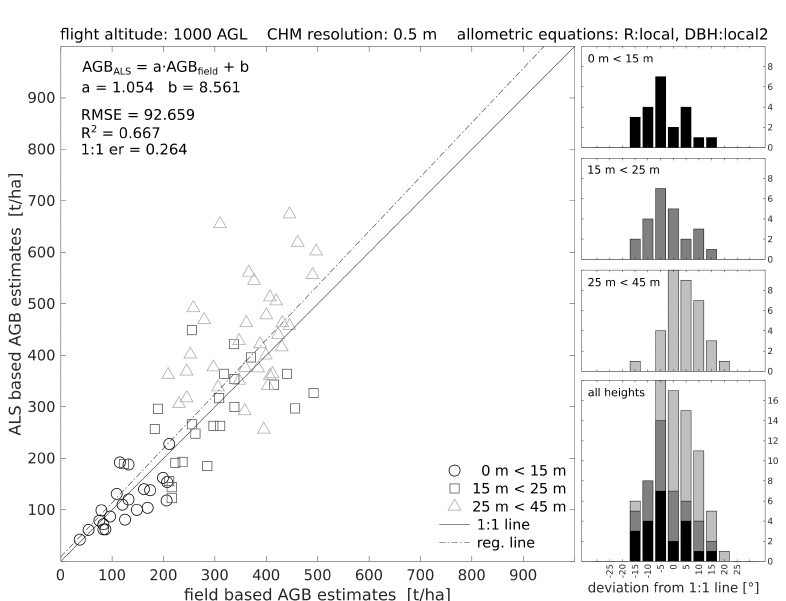
Figure 6. AGB comparison at plot level between estimates based on field data and ALS data (scenario based on the CHM raster with pixel size of 0.5 m and combination of two local models, one for tree crown R estimation and the other for the stem diameter at breast height estimation). The linear regression line (dash-dot) is presented together with the 1:1 line (solid) and symbols differentiate tree height categories. Histograms on the right-hand side show deviation from the 1:1 line for different tree height